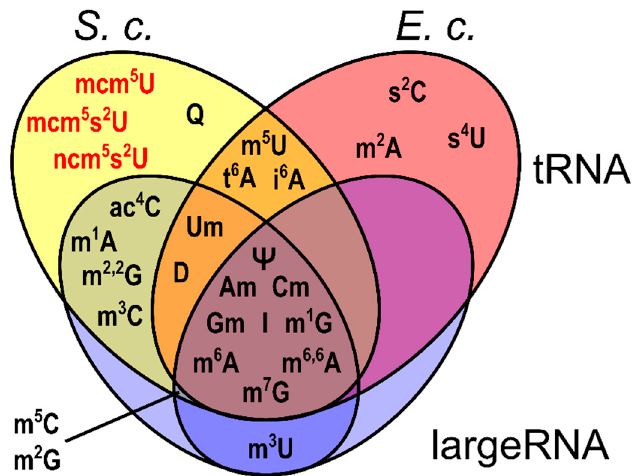
Figure 3. Venn diagram of modified nucleosides, which are produced in the presented SILIS preparation. S. c. : Saccharomyces cerevisiae ; E. c. : Escherichia coli . Color code: tRNAs, red and yellow; large RNAs, blue. Red text: Wobble uridines. The full names of the abbreviated modified nucleosides are found in Table 1.